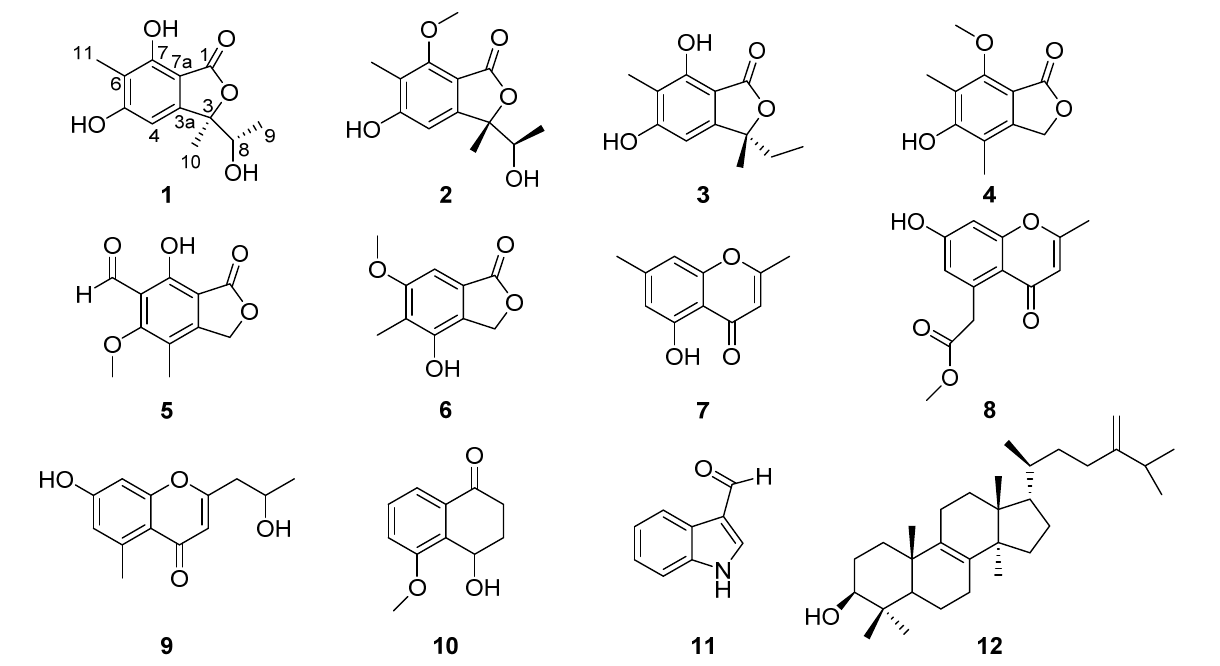
Figure 1. Structures of compounds 1–12 .